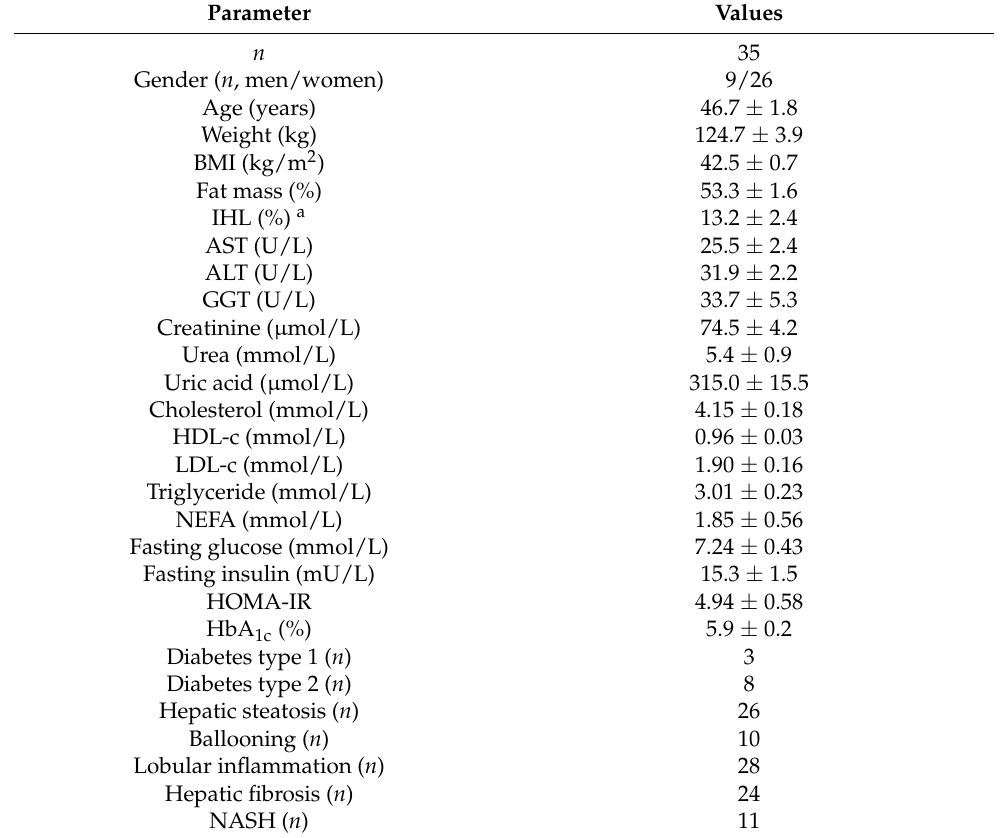
Table 1. Baseline Anthropometric and Clinical Parameters of Study